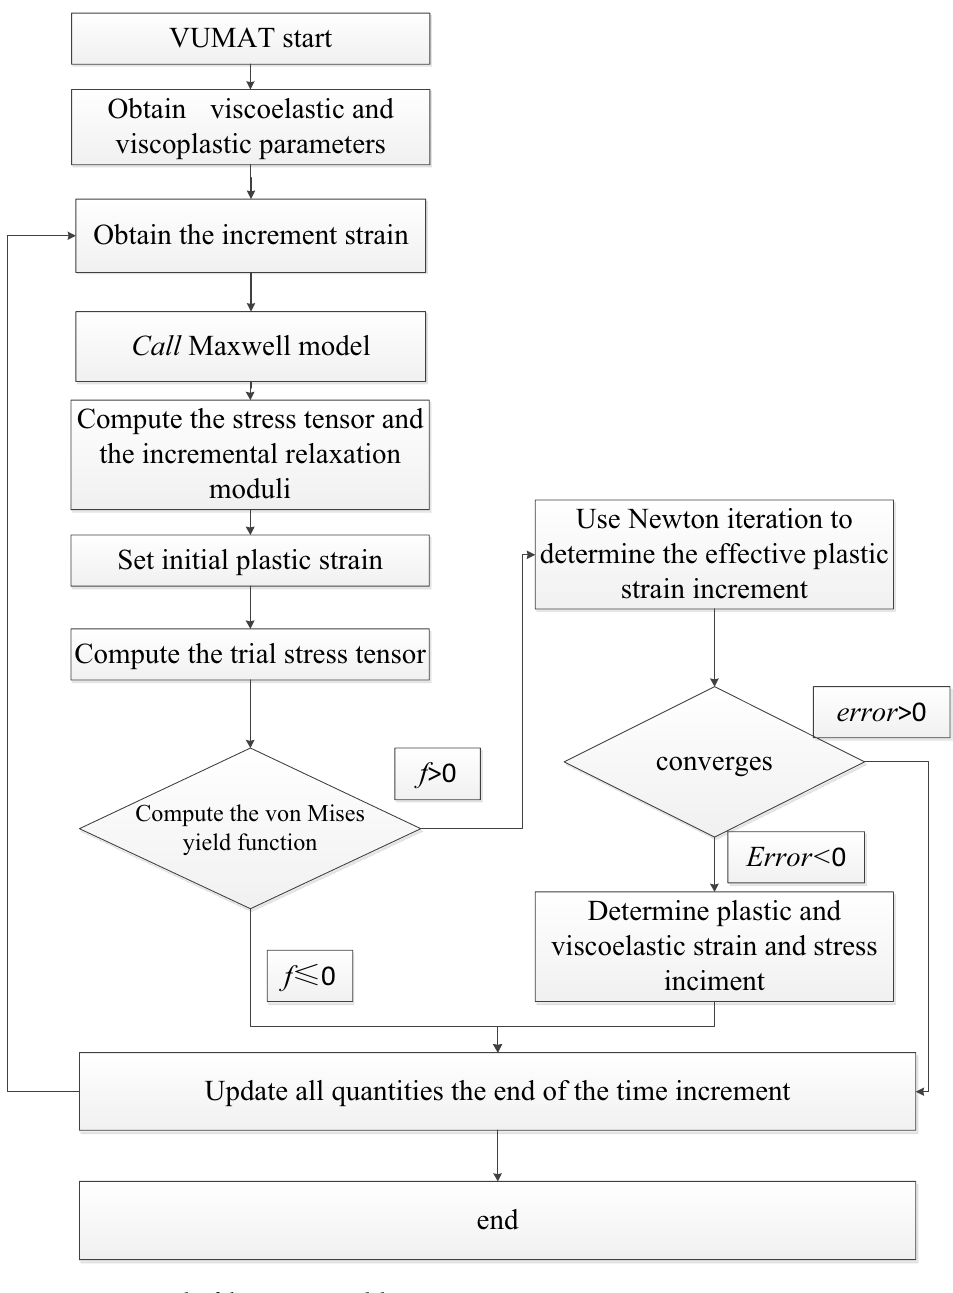
Figure 1. Framework of the VE–VP